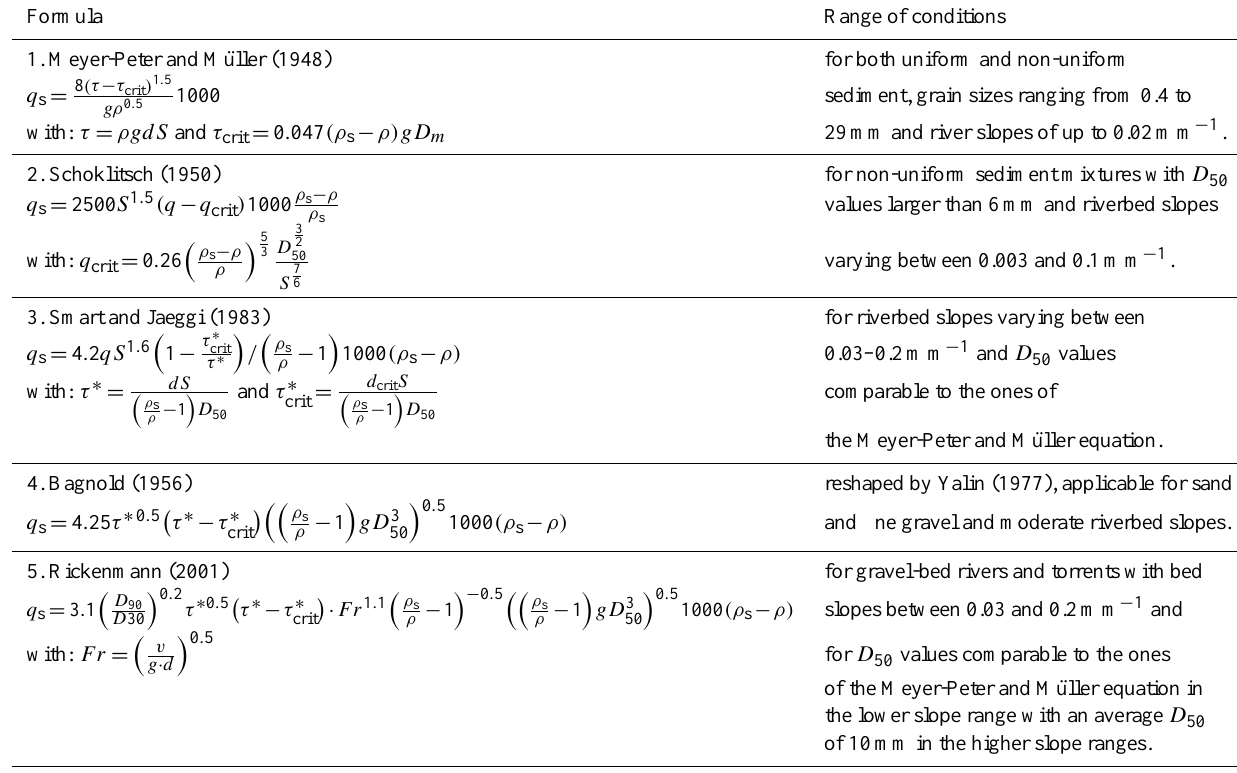
Table 1. Bedload transport formulae in the river module. Formula Range of